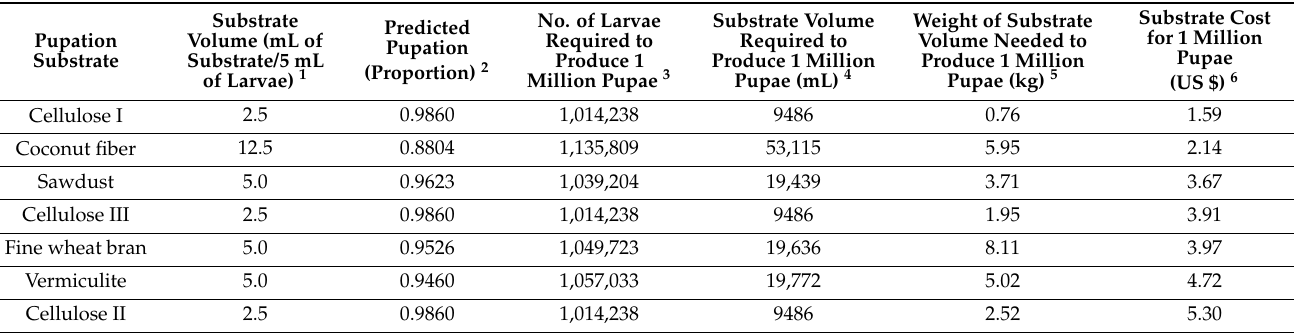
Table 2. Estimated quantities of third instar C. capitata VIENNA 8 GSS larvae and cost of pupation substrates at selected volumes required to produce one million pupae. Pupation substrates are listed from the lowest to highest cost for one million